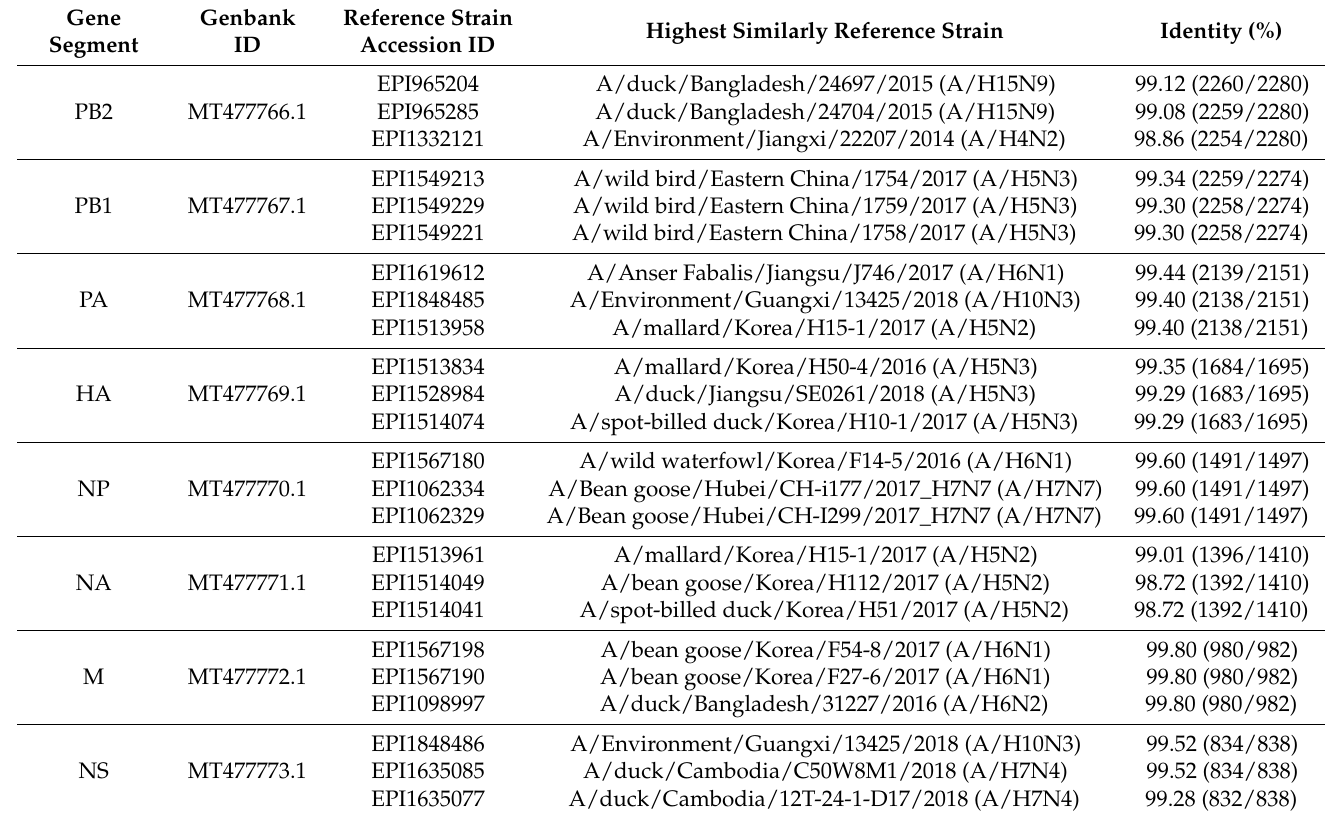
Table 1. Sequence homology of the whole A/Wild duck/South Korea/KNU18-28/2018 (A/H5N2) genome. Gene